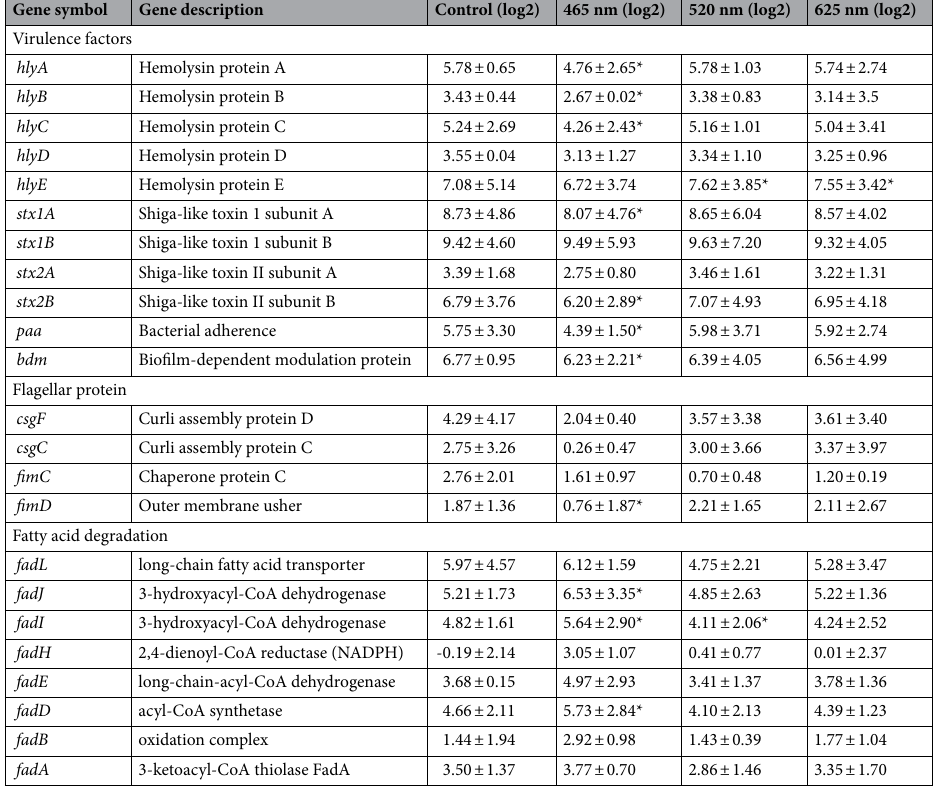
Table 3. Genes up- and/or down-regulation in E. coli O157:H7 under 465 nm, 520 nm and 625 nm LED illuminated and non-illuminated control cells. *Indicate significant difference ( P < 0.05) between 465 nm; 520 nm and 625 nm illuminated light in comparison with